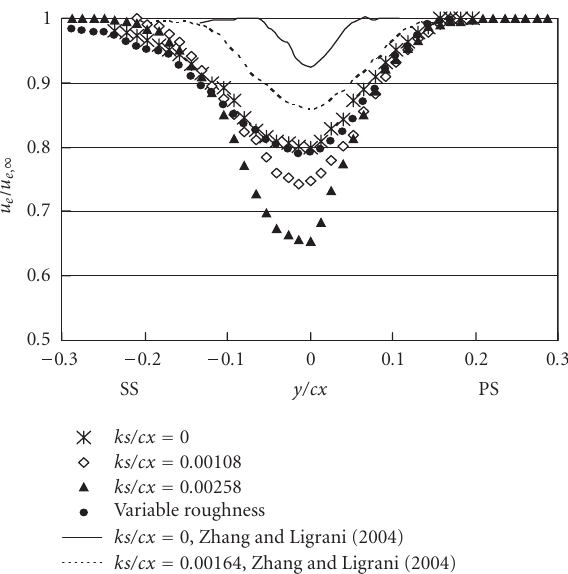
Figure 4: Normalized wake mean velocity distributions measured one axial chord length downstream of the cambered airfoils with di ff erent rough surfaces for Tu = 1 . 1